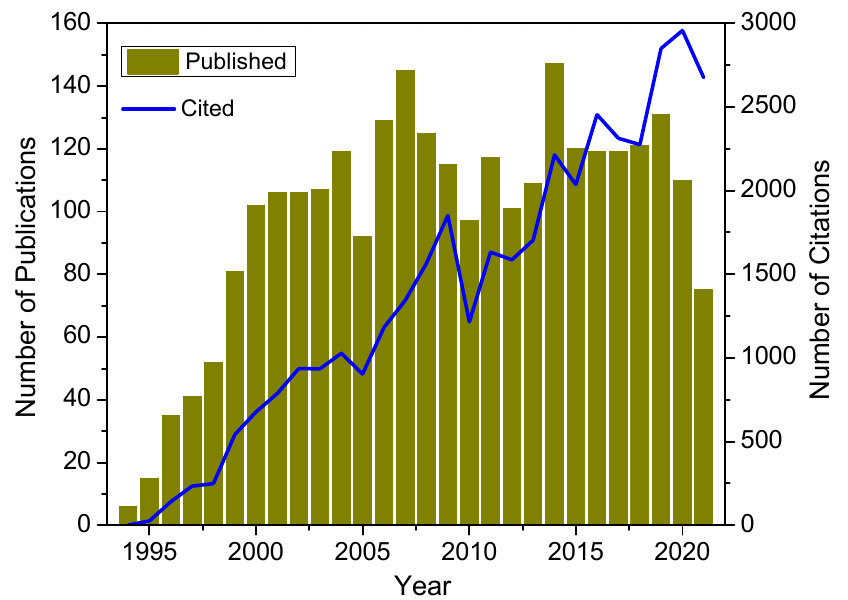
Figure 1. Number of published articles and citations per year in the field of magnetoimpedance materials and sensors. The data were collected from Web of Science with “magnetoimpedance” or “magneto-impedance” as a keyword.